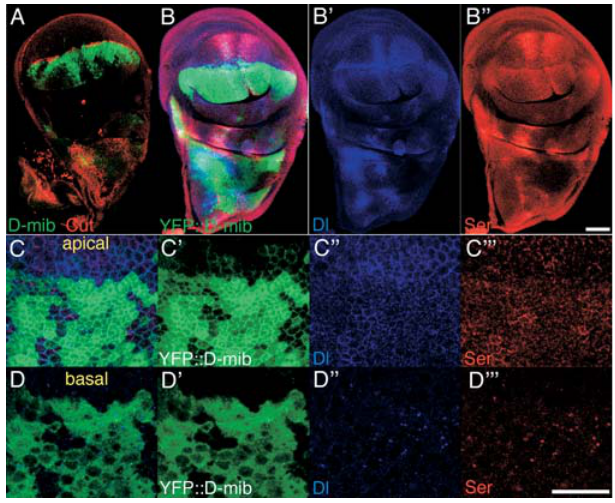
Figure 7. Expression of D-mib in Dorsal Cells Is Sufficient to Rescue the D-mib Mutant Phenotype (A) Expression of D-mib (green) in dorsal cells, using Ser-GAL4, rescued the growth of the wing pouch and margin Cut (red) expression in D-mib 2 / D-mib 3 mutant discs. (B–D 999 ) Ser-GAL4-driven expression of YFP::D-mib (green) rescued the D-mib 2 / D-mib 3 phenotype and strongly reduced the level of Dl (blue in [B, B 9 , C, C 99 , D, and D 99 ]) and Ser (red in [B, B 99 , C, C 999 , D, and D 999 ]) in dorsal cells. (C–D 999 ) are high-magnification views (apical [C– C 999 ] and basal [D–D 999 ]) of the disc shown in (B–B 99 ). YFP::D-mib co- localized with Dl and Ser at the apical cortex in cells expressing only low levels of YFP::D-mib.